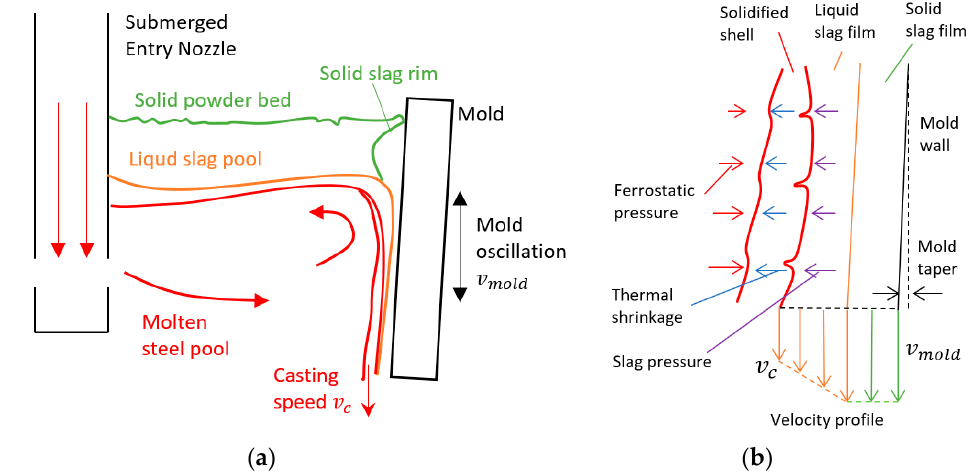
Figure 1. ( a ) Schematic of continuous casting and ( b ) magnified view in mold–strand gap (not